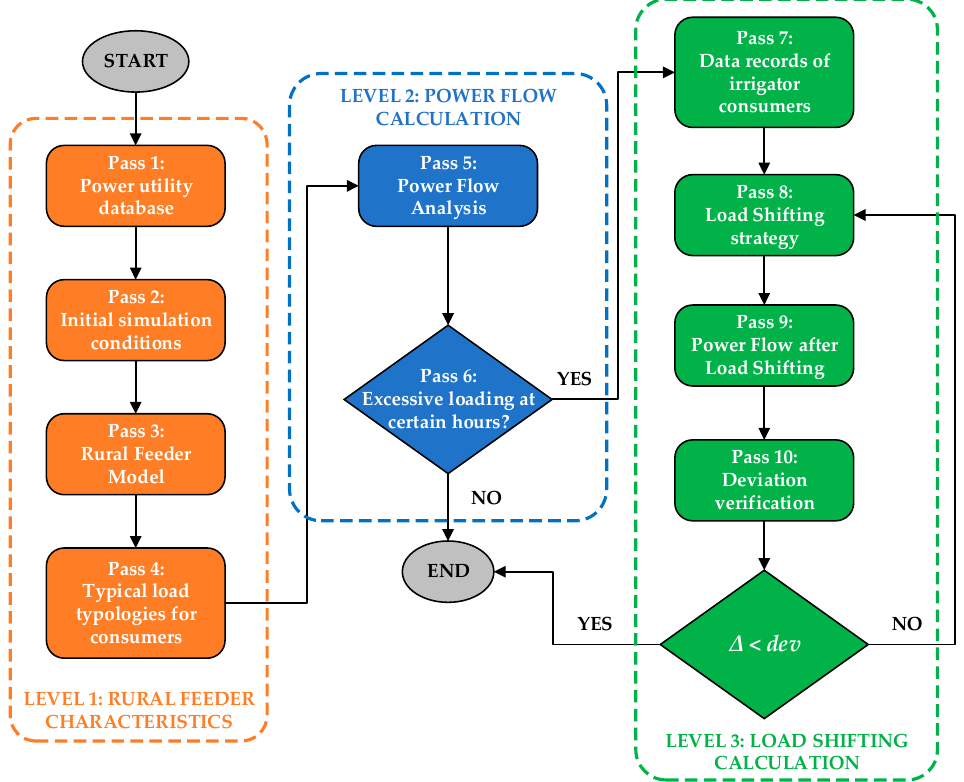
Figure 1. Flowchart presenting the sequential steps of the demand management methodology. Source: The